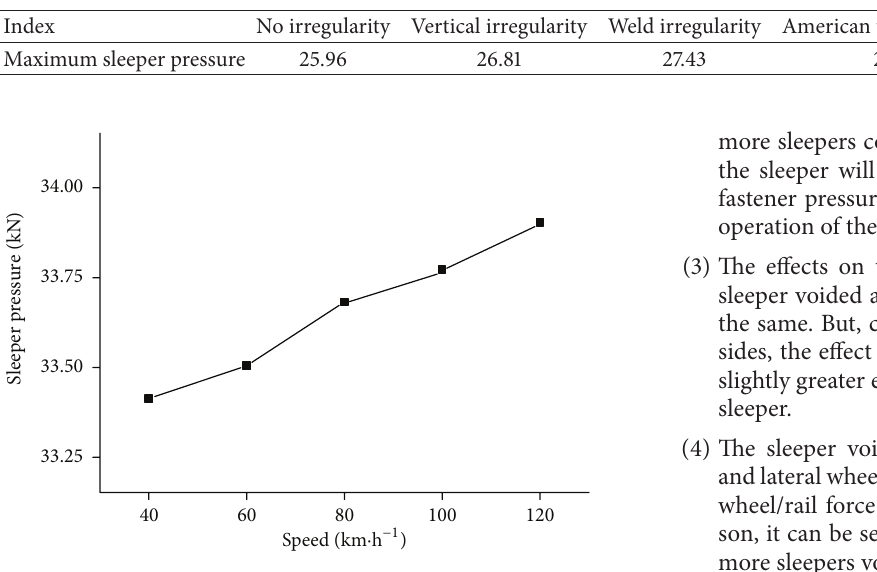
the maximal pressures on sleeper change caused by elastic two-block voided